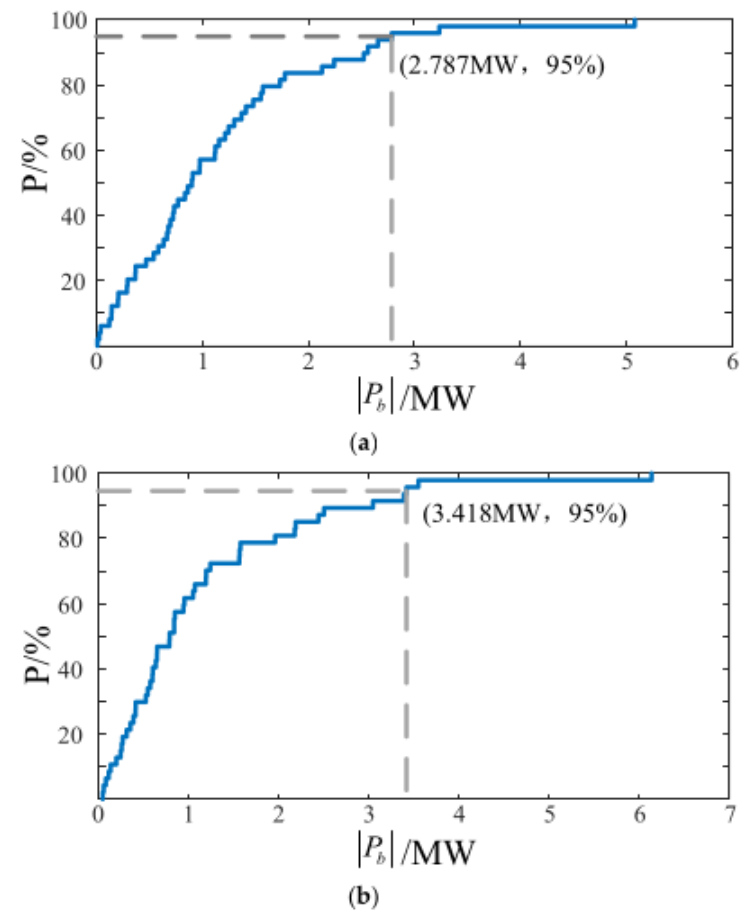
Figure 5. Cumulative probability distribution of energy storage power. ( a ) Cumulative probabil- ity distribution of charging power of energy storage; ( b ) Cumulative probability distribution of discharging power of energy